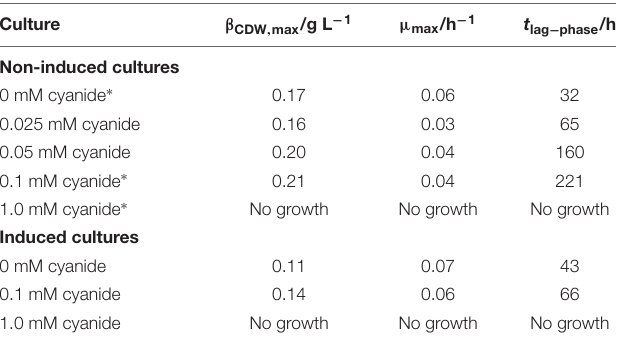
TABLE 2 | Results for CDW, growth rate, and lag-phase of autotrophic cultures in the presence of different concentrations of cyanide. Culture